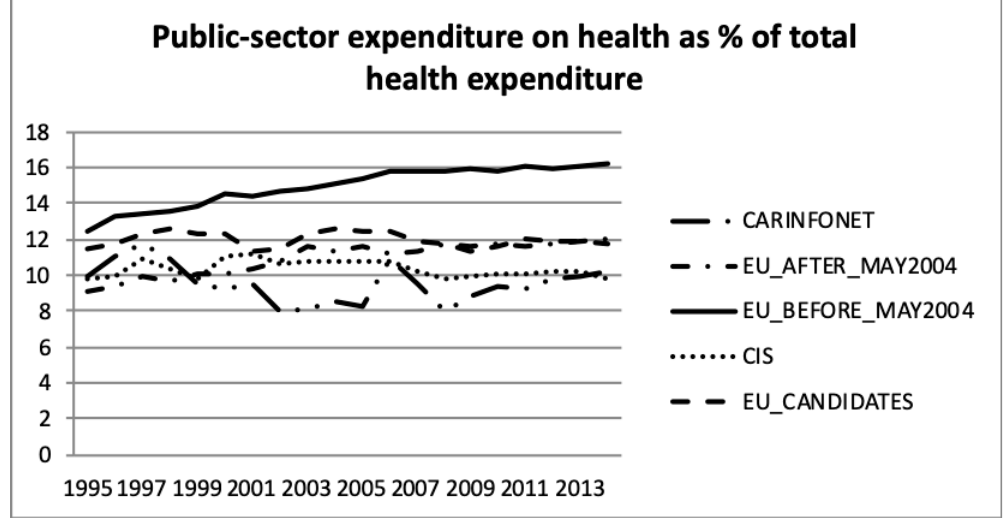
Figure 7. Public sector expenditure on health as a percentage of total health expenditure, the World Health Organisation estimates. Int. J. Environ. Res. Public Health 2019 , XX , x